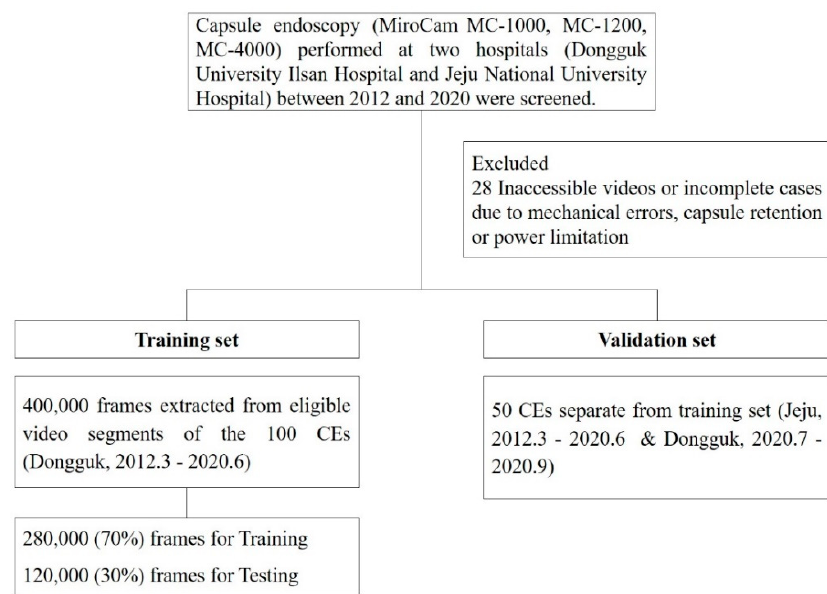
Figure 1. Data flow. CE, capsule endoscopy.